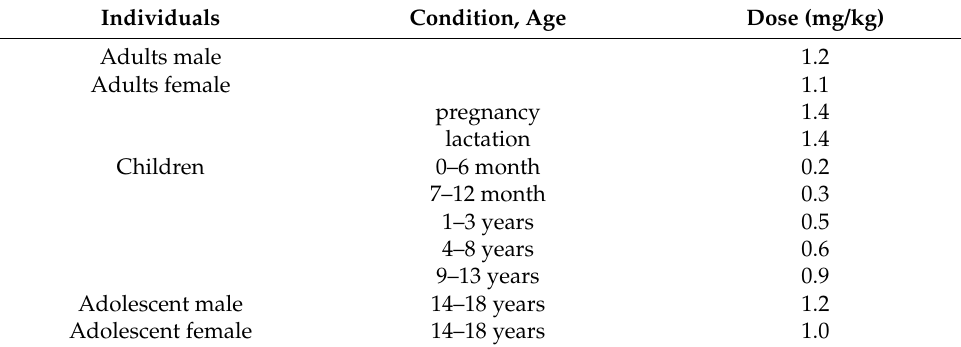
Table 4. Recommended dietary allowances for